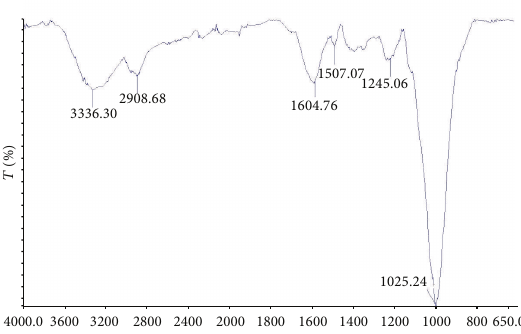
Figure 1: FTIR spectrum of biosorbent material.